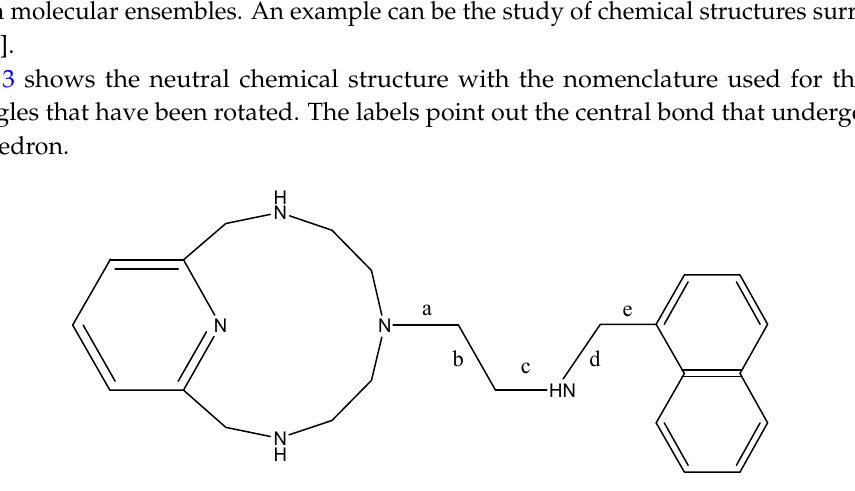
Figure 3. Labels for the dihedral angles in the pendant arm.